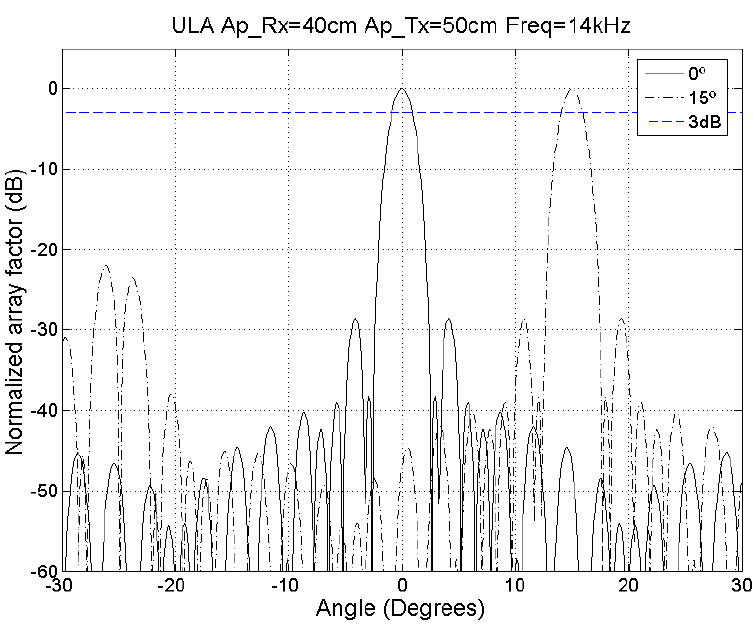
Figure 16. Beampattern for 0 ° and 15 ° for f = 14kHz.